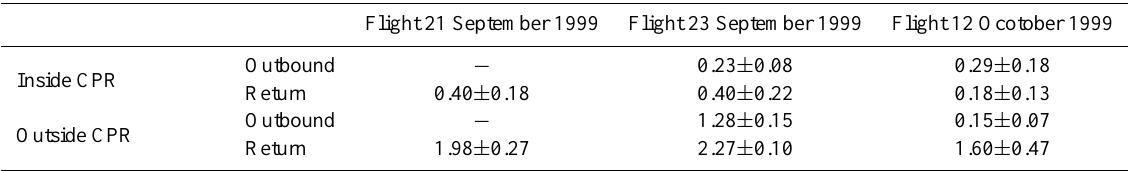
Table 2. Mean ozone mixing ratios (ppmv) above the 415K isentrope, measured by the APE-GAIA mission in September and October 1999. Standard deviations are reported along with the means. “CPR” stands for chemically perturbed region.